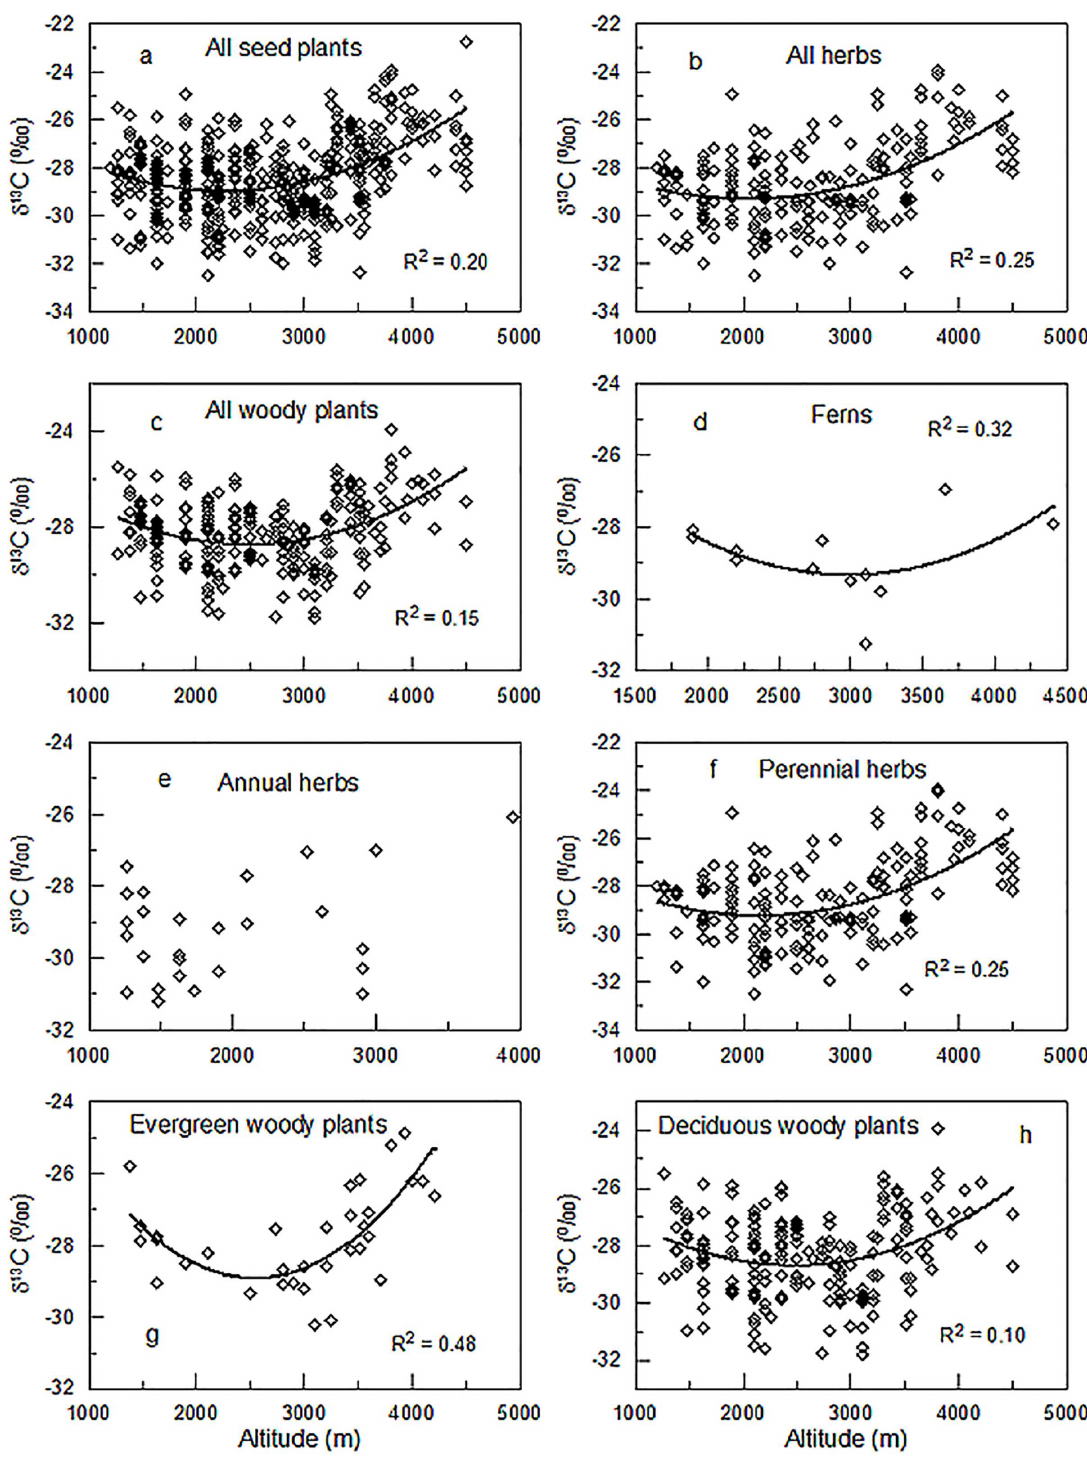
Fig 2. Variations in leaf δ 13 C with altitude for different functional groups. a: seed plants; b: herbaceous plants; c:woody plants; d: ferns; e:annual herbaceousplants; f:perennial herbaceous plants; g:evergreenwoody plants; h: deciduous woody plants.